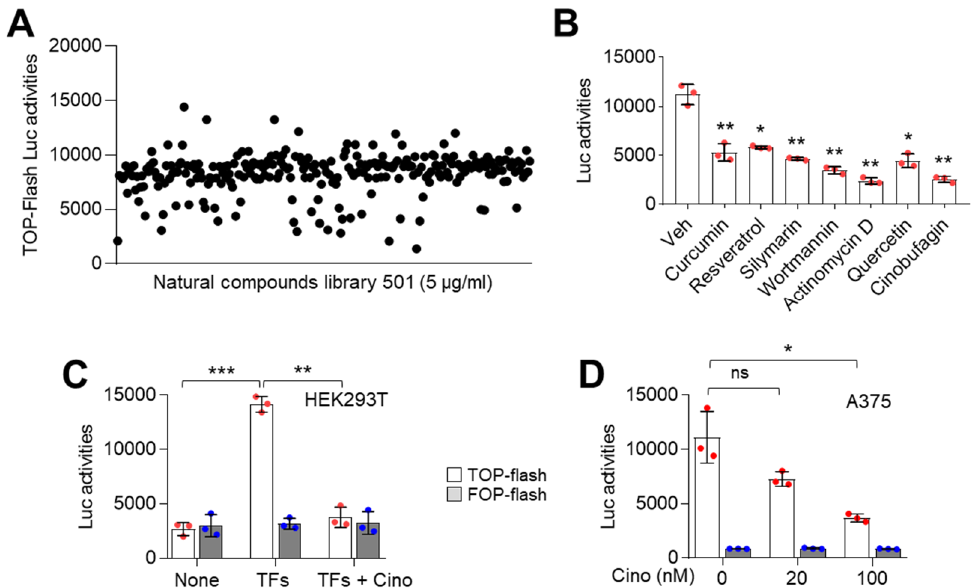
Figure 2. TOP-flash luciferase assay-based high throughput screening for β -catenin / TCF4 inhibiting natural compounds. ( A ) TOP-flash luciferase activities were suppressed by several natural compounds. HEK293T cells were transiently co-transfected with TOP-flash luciferase, pcDNA / Myc-TCF4, pBABE-puro-LEF1, and pcDNA3- β -catenin. Transfected cells were incubated for 24 h with natural product library 502 as described in the Materials and Methods section. Hit compounds were selected by following decreased fold change three times compared to DMSO control. ( B ) Hit compounds inhibit TOP-flash luciferase activities in A375 melanoma cells. TOP-flash luciferase plasmids transfected A375 cells were incubated for 24 h with 5 µ M of hit compounds as indicated. The values represent the mean ± SD ( n = 3); * p < 0.05 and ** p < 0.01. ( C ) Cinobufagin as a potent inhibitor of β -catenin / TCF4 suppresses TOP-flash luciferase activities. HEK293T cells were transfected with transcription factors (TFs) including pcDNA / Myc-TCF4, pBABE-puro-LEF1, and pcDNA3- β -catenin which activates β -catenin / TCF4 signaling. Transfected HEK293T cells were incubated for 24 h with 5 µ M of cinobufagin. The values represent the mean ± SD ( n = 3); ** p < 0.01 and *** p < 0.001. ( D ) Cinobufagin inhibits β -catenin / TCF4 transcriptional activities in A375 melanoma cells in a dose-dependent manner. A375 cells were transfected with TOP or FOP-flash luciferase plasmids. Transfected A375 cells were incubated for 24 h with 20 or 100 nM of cinobufagin. The values represent the mean ± SD ( n = 3); * p < 0.05. Red and blue points, mean value of individual sample.